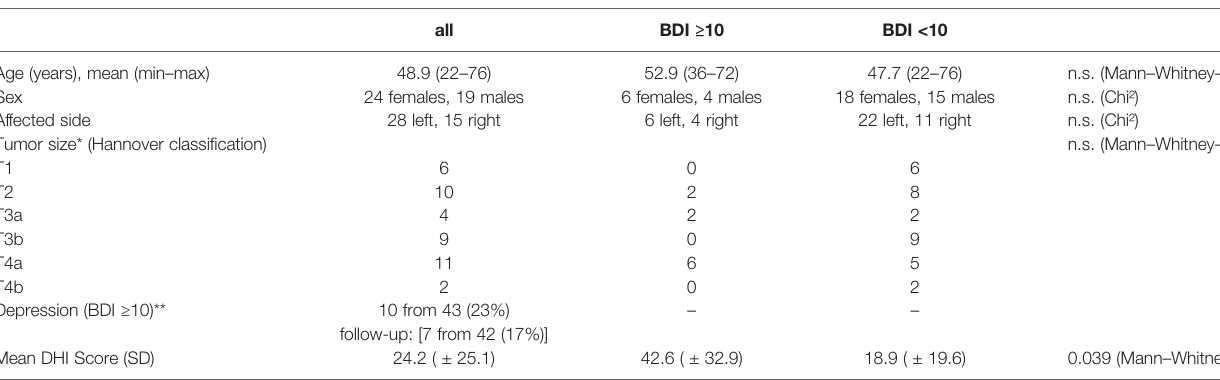
TABLE 1 | Demographics and clinical data.